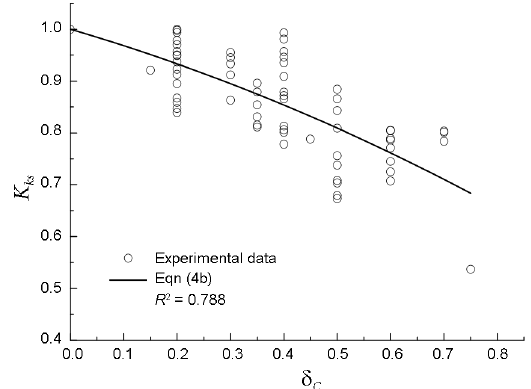
Figure 2. Relationship between K ks and concrete compressive stress